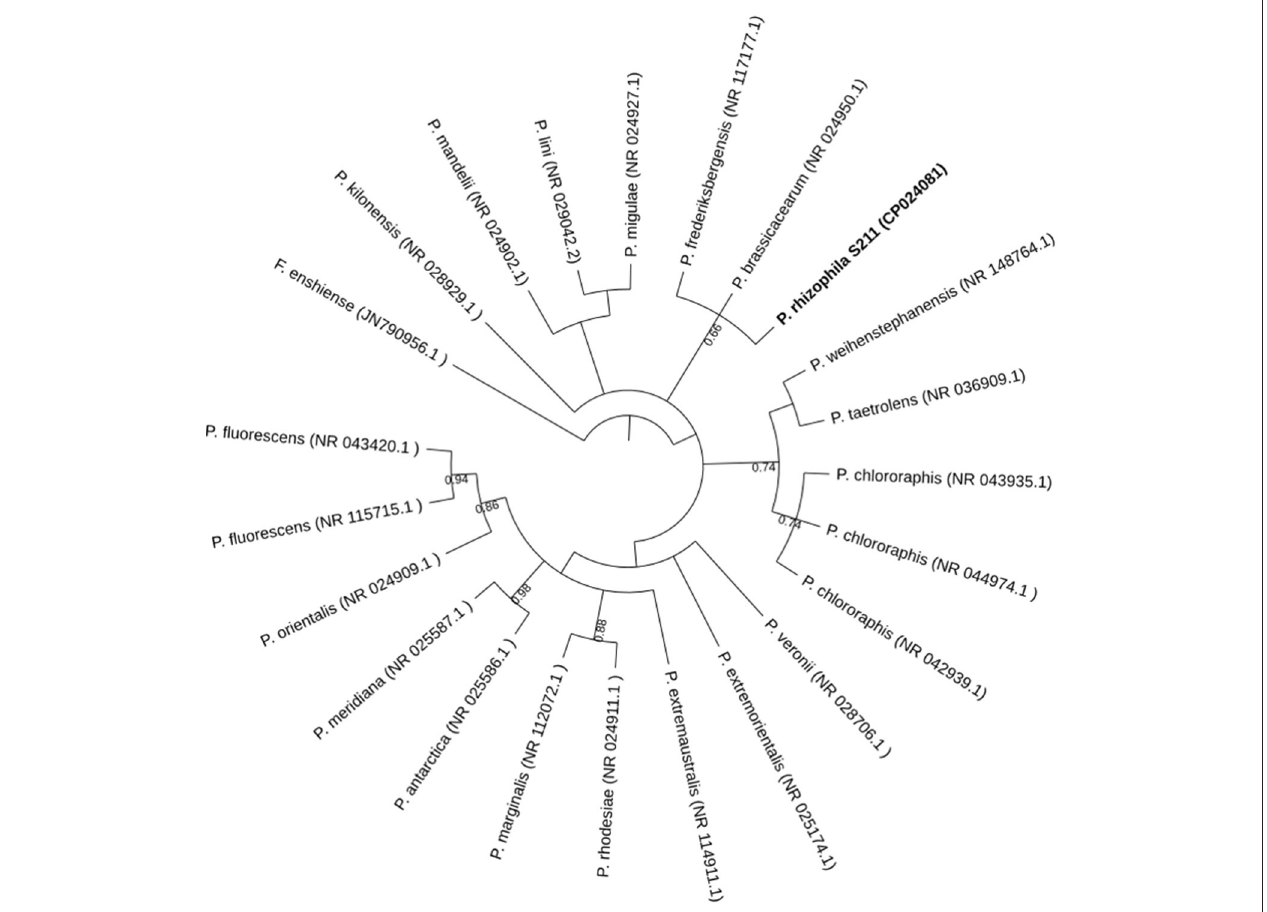
FIGURE 1 | Phylogenetic tree generated with Mr. Bayes based on 16S rRNA gene sequences of P. rhizophila S211 isolate and related species. The tree was rooted with Flavobacterium enshiense (N790956.1) as an out-group. Bootstrap values are expressed as randomization of 1,000. GenBank accession numbers of the reference strains are